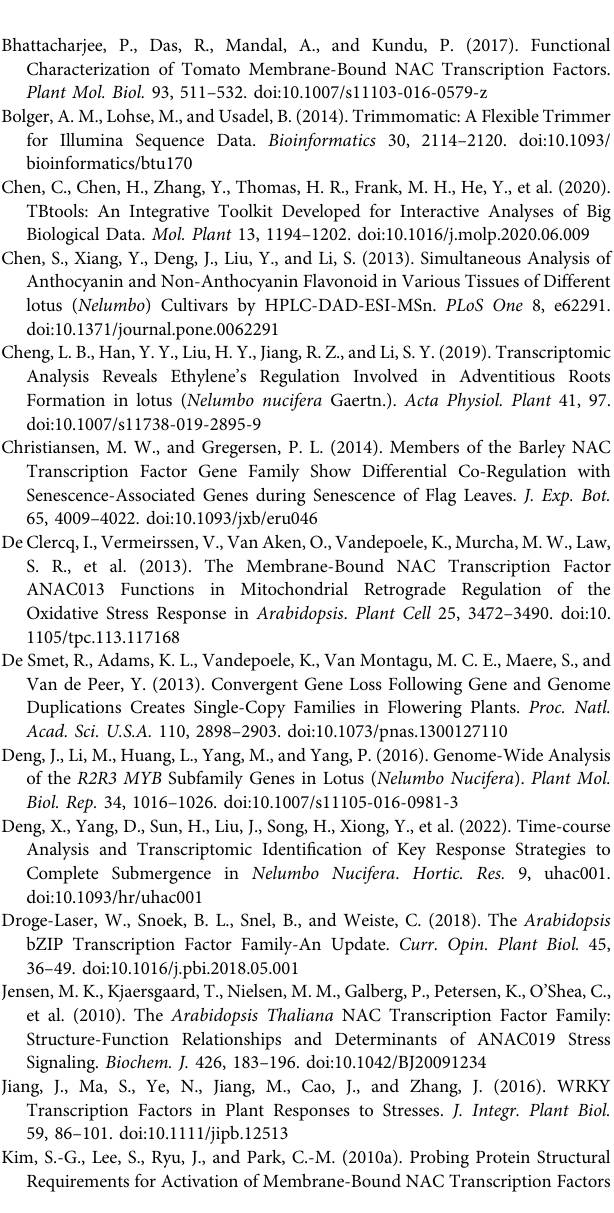
Supplementary Table S1 | Primer sequences used for vector construction and qRT-PCR validation. Supplementary Table S2 | Protein sequences of NnNAC genes. Supplementary Table S3 | Statistical analyses of sequence length, molecular weight, isoelectric point, and predicted subcellar localizations for NAC proteins in lotus. Supplementary Table S5 | The expression of NnNAC DEGs involved in lotus seed development (FPKM